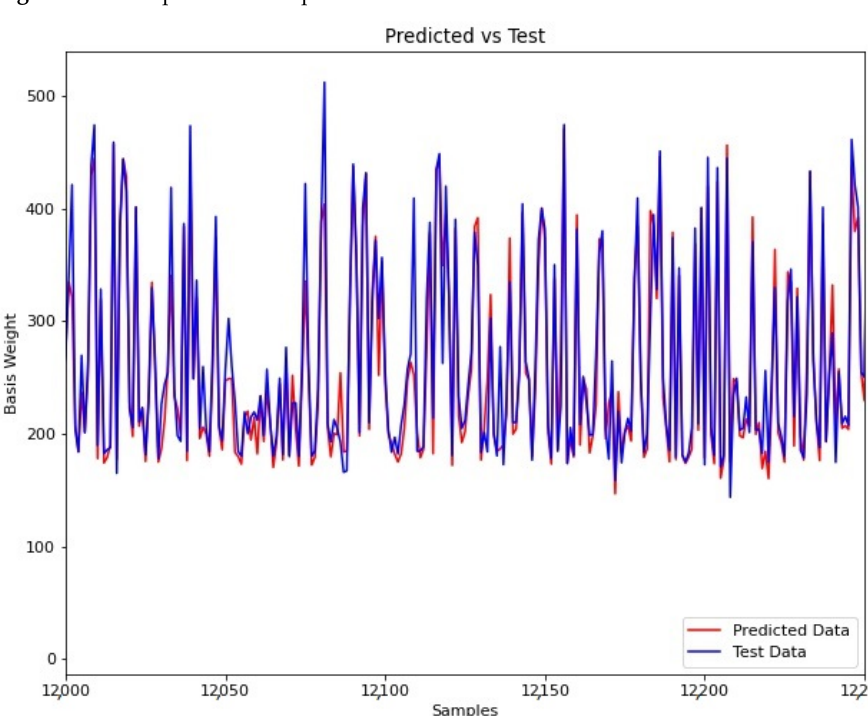
Figure 3. Model performance: predicted vs. test data.